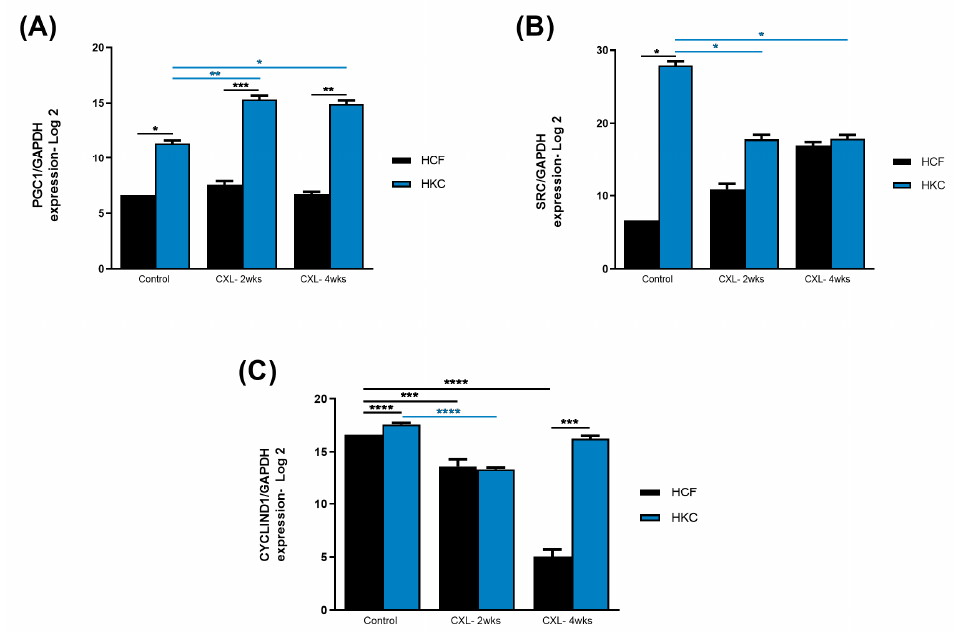
Figure 4. Protein expression of ( A ) PGC1, ( B ) SRC, and ( C ) cyclin D1 in HCF and HKC 3D constructs following CXL treatment after 2 and 4 weeks. Constructs without treatment serve as controls. * represents p < 0.05, ** represents p < 0.01, *** represents p < 0.001, and **** represents p < 0.0001.